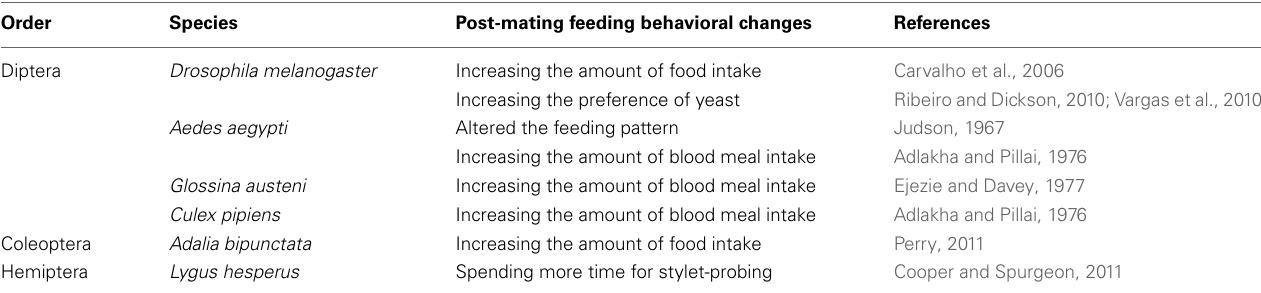
Table 1 | Post-mating feeding behavior changes in several insect